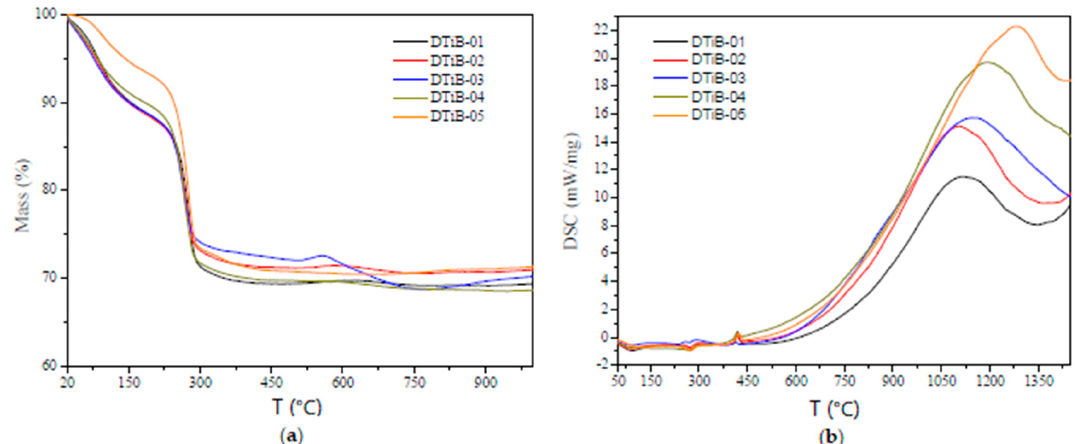
Figure 6. ( a ) Thermogravimetric (TG) and ( b ) differential scanning calorimetry (DSC) analysis for all the CD-aTiO 2 photocatalysts synthetized and used in this work. Table 1. Some parameters of the characterization results for all the CD-aTiO 2 photocatalysts obtained under different microwave heating conditions.